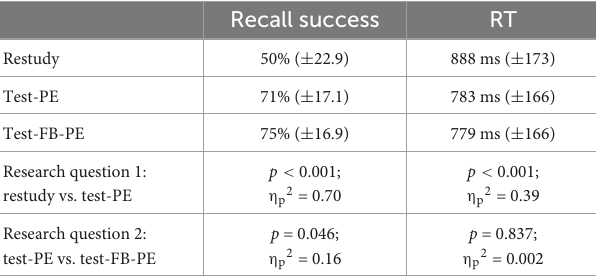
SD = 13.7; Test-PE: M = 42.8, SD = 10.3; Test-FB-PE: M = 44.9, SD =